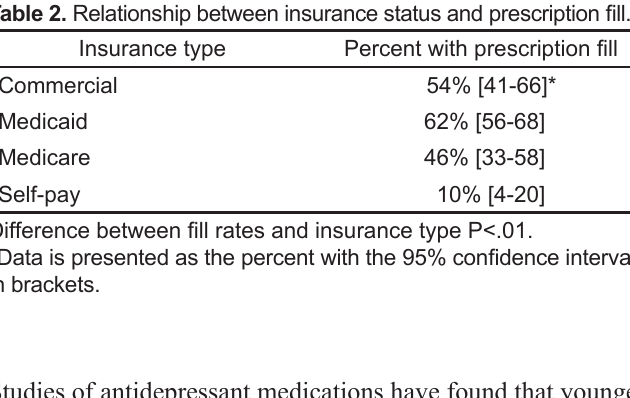
Table 2. Relationship between insurance status and prescription fill.